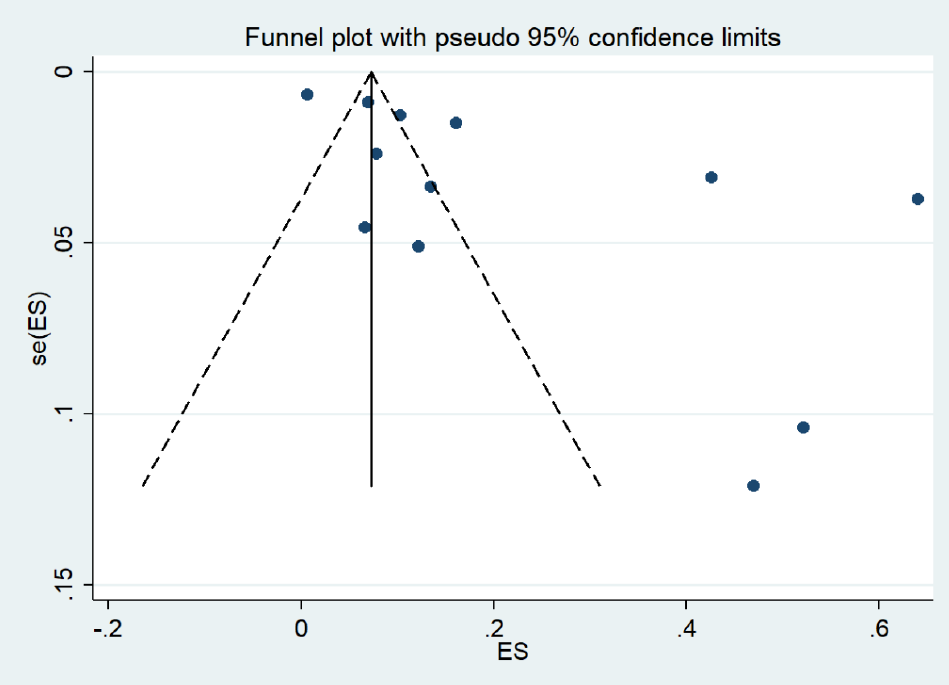
Figure 19. Funnel plot . Abbreviations; es, effect size; se ( es ) , standard error of the es .